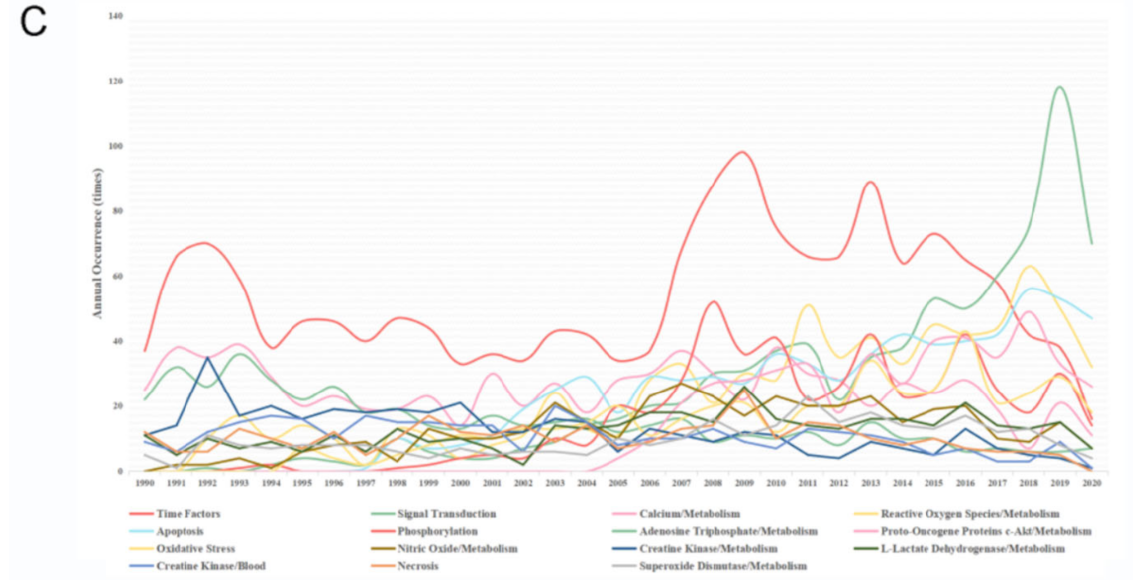
Figure 5. MeSH terms in relation to the pathogenesis of myocardial reperfusion injury. ( A ) accumulated occurrences of the top 15 MeSH terms every ten years; ( B ) accumulated occurrences of the top 5 MeSH terms with the greatest increasing trend; ( C ) annual occurrences of the top 15 MeSH